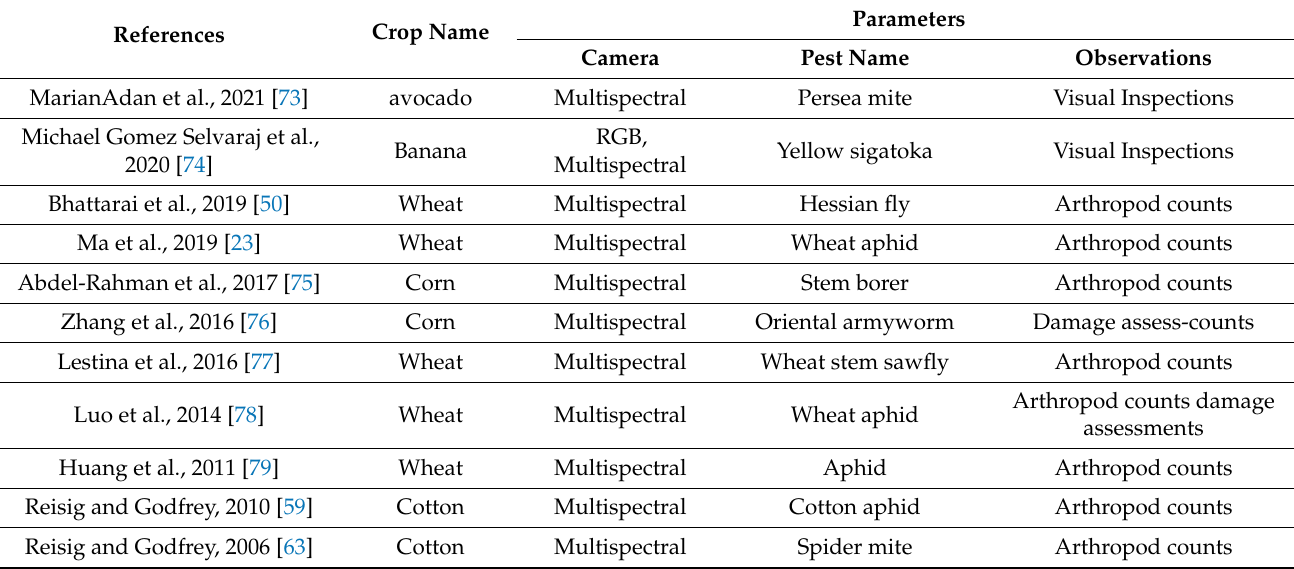
Table 5. Orbital (Satellite) based remote